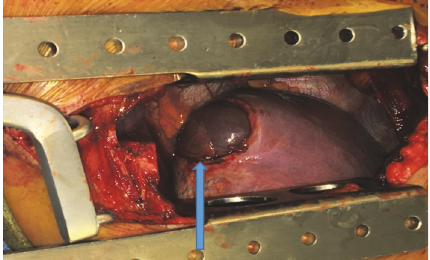
Figure 3: Blue arrow showing large diaphragmatic defect with herniation of liver before